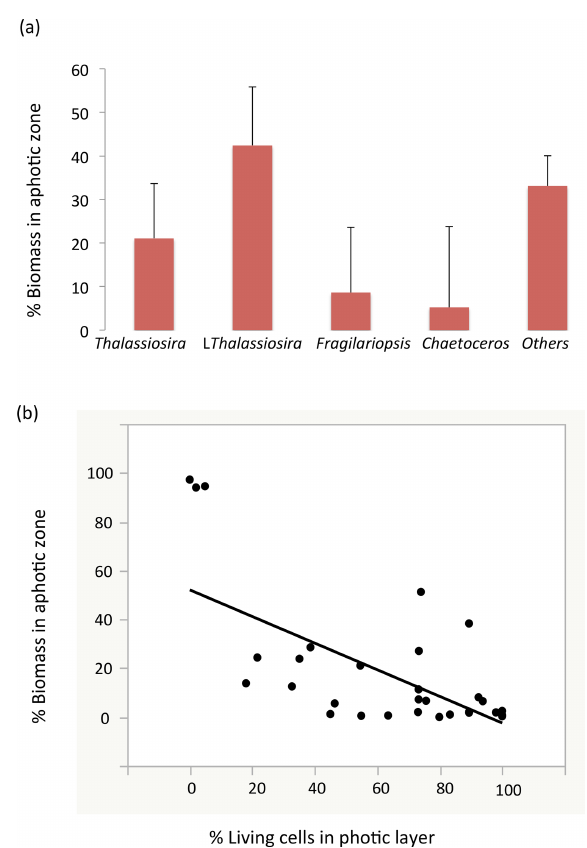
Figure 5. (a) The proportion (mean ± SE) of the water-column stock observed in the aphotic zone (relative to the sum of the aphotic and photic zones) among the different diatom taxa. (b) The rela- tionship between the percentage of living diatoms cells among the different populations in the photic layer and the proportion of the water-column population stock observed in the aphotic zone. The line represents the fitted linear regression ( R 2 = 0 . 39, P < 0 .